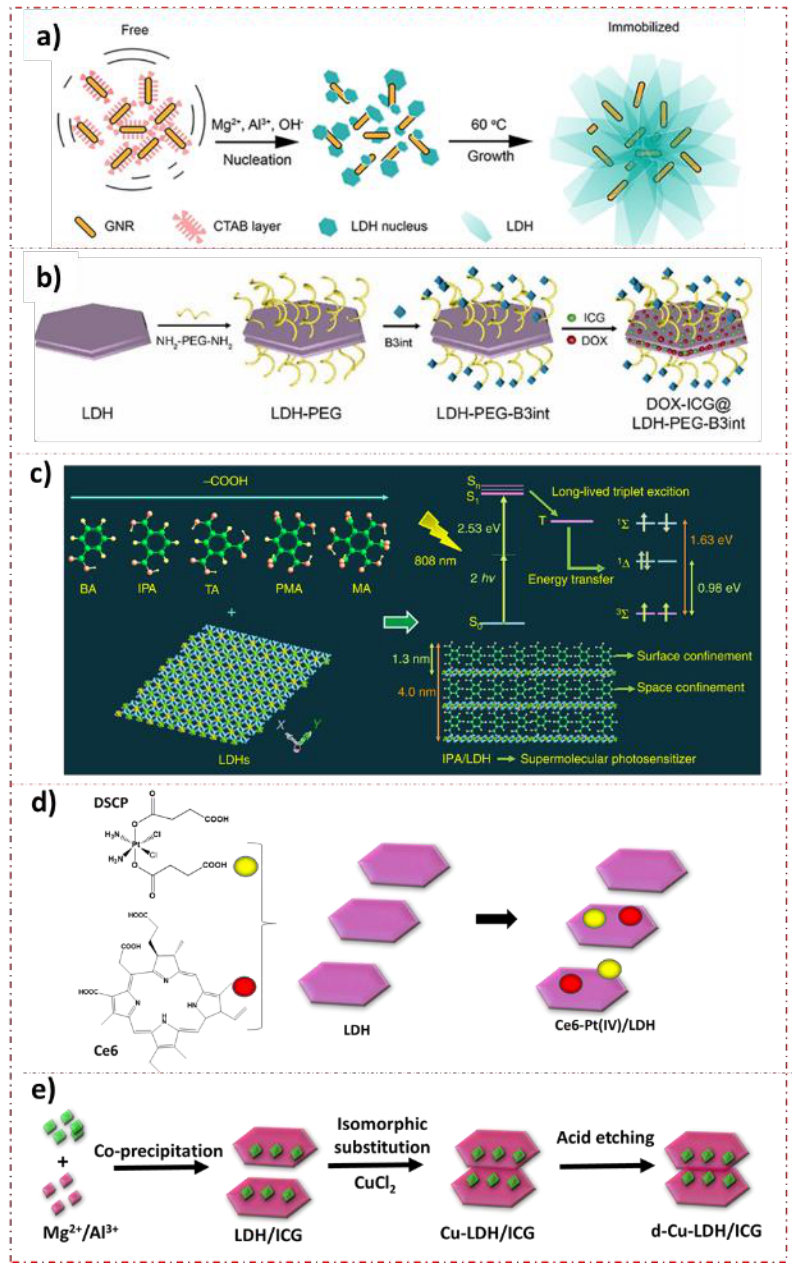
Figure 1. ( a ) Synthesis scheme of gold nanorods (GNR)@layered double hydroxide (LDH) (copyright from ACS-2019). ( b ) Novel two-dimensional (2D) bio-nanohybridization strategies for photochemotherapy applications. Schematic illustration of the synthesis of doxorubicin (DOX)-indocyanine green (ICG) and LDH-PEG-B3int((arginine-tryptophan-(D-arginine)-asparagine- arginine)) nanoparticles (copyright from Elsevier, 2019). ( c ) Illustration of nanohybrids as two-photon photosensitizers for 1 O 2 generation. Schematic representation of the LDH host and five aromatic RTP guest species. Two-dimensional-confined long-lived triplet excitons can function as photosensitizers to achieve efficient 1 O 2 generation under 808nm near-infrared laser power (copyrights under Cre- ative Commons Attribution 4.0 International License, Nature , 2018). ( d ) Overview of the strategy to co-deliver the Pt(IV) prodrug, DSCP (c,c,t-(diamminedichlorodisuccinato) Pt (IV), and the photosen- sitizer, Ce6 (chlorin e6), using LDH nanoparticles. ( e ) Synthetic steps involved in the development of trimodal photothermal therapy/photodynamic chemotherapy using d-Cu-LDH/ICG